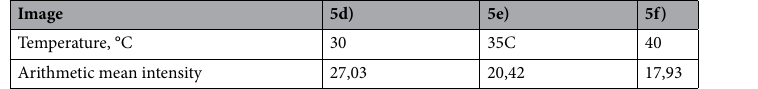
Table 3. Mean intensity values at 546 nm measured by fluorescent microscopy at different